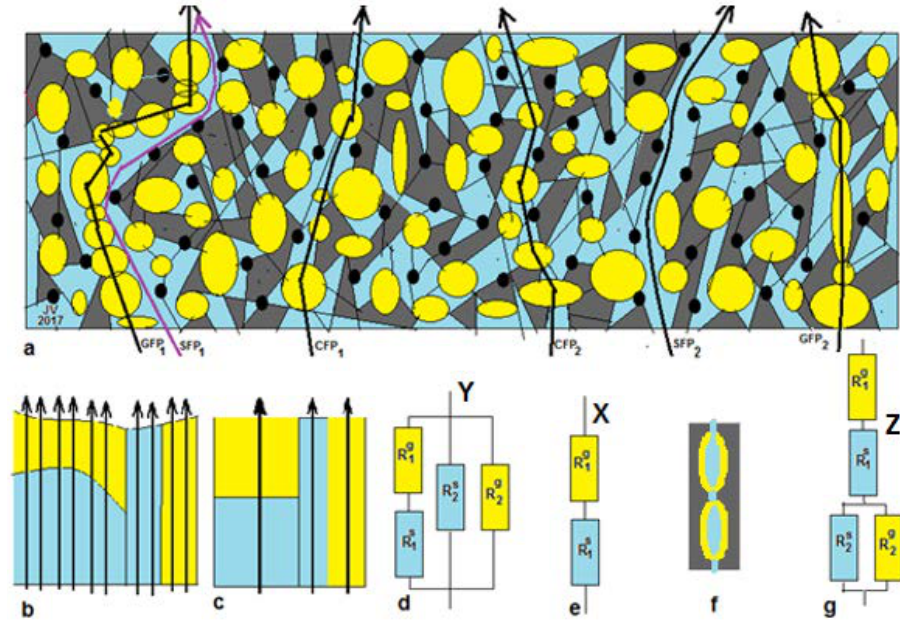
Figure 1. ( a ) An ion exchange membrane with four different phases: reinforcement (black), non-conducting polymer (gray), gel (yellow), and solution phase (blue). Some flow paths of the ionic current are shown: combination flow paths (CFP 1 and CFP 2 ), gel phase flow path (GFP 1 and GFP 2 ) as well as solution flow paths (SFP 1 and SFP 2 ). ( b ) The model after rearranging the different phases. ( c ) A simplification of the rearranged model called a ‘3-thread model’. ( d ) Electrotechnical representation of the 3-thread model (further called ‘model Y’). ( e ) Ultimate simplification of the 3-thread model: the 1-thread model (or ‘model X’). ( f ) Gierke model with solution-filled gel vesicles. ( g ) Representation of the Gierke model (or ‘model Z’).